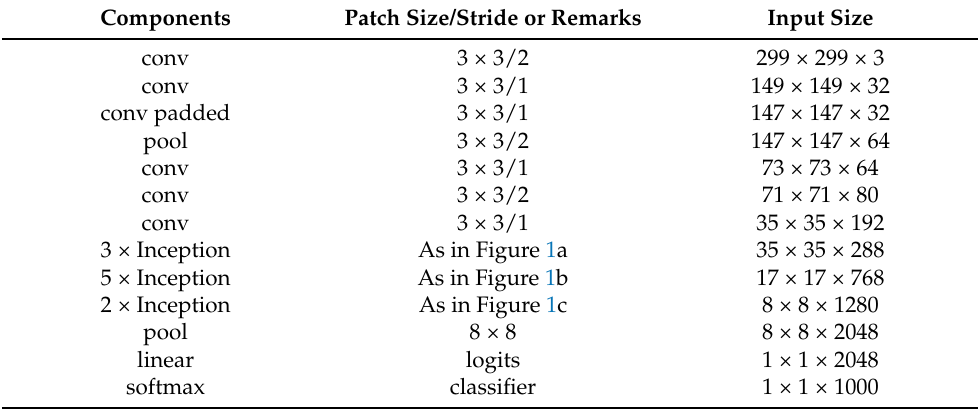
Table 2. The network architecture of Inception